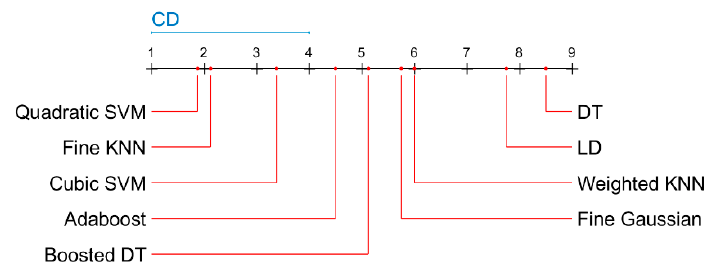
Figure 11. Critical difference diagram of the Nemenyi test results for malware classification using SFTA features (imbalanced dataset). CD is critical difference.